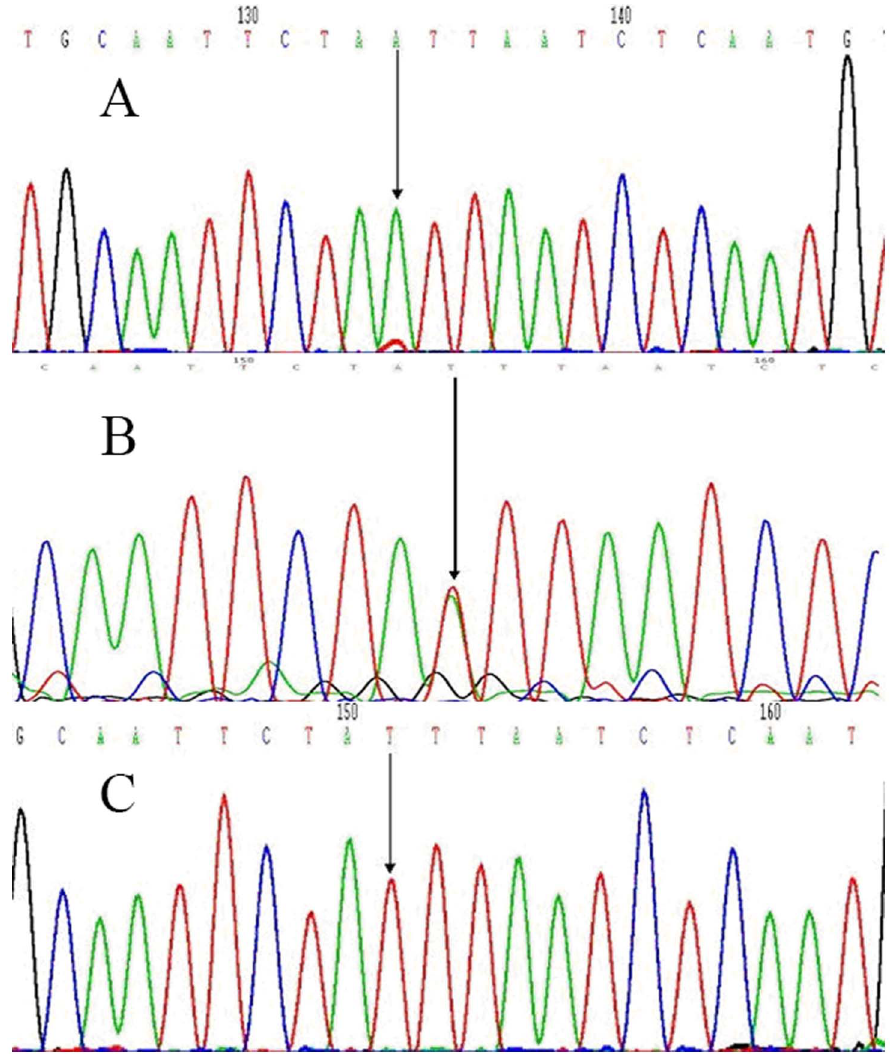
Figure 3. Sequenced diagrams of the PCR amplification production of the rs10507391. (A) A unimodal arrowed was homozygous AA. (B) A/T bimodal arrowed was heterozygous AT. (C) T unimodal arrowed was homozygous TT.